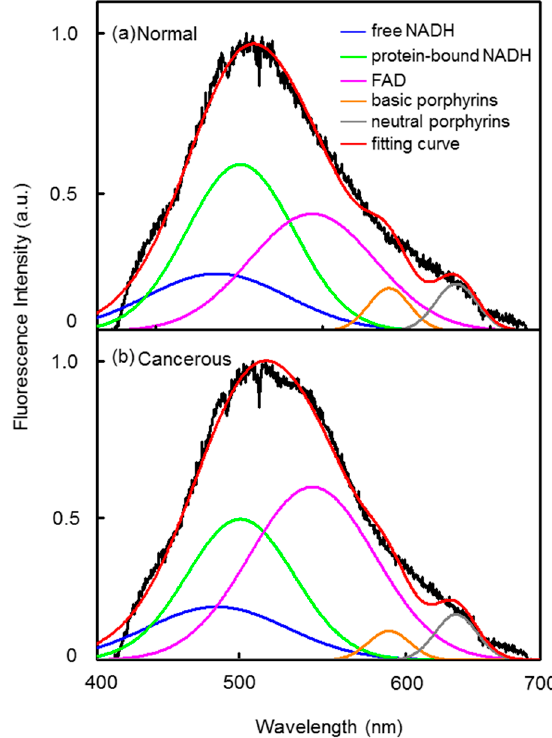
Figure 3. Two example spectra curves of ( a ) normal and ( b ) cancerous lung tissue samples.